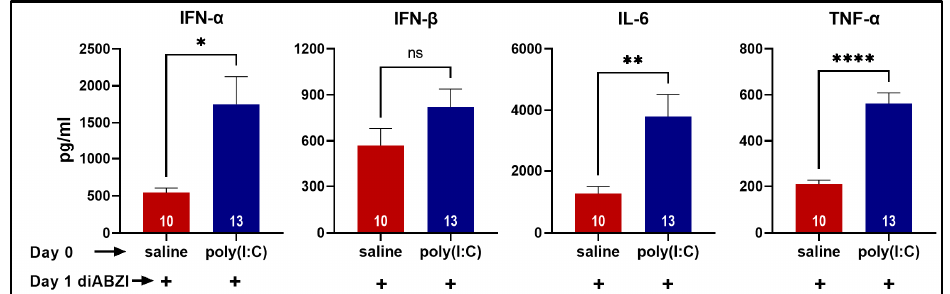
Figure 7. Exaggerated serum cytokine levels after subcutaneous injection of diABZI in mice pre- treated with poly (I:C). On day 0, mice were injected with either poly (I:C) in saline (2 mg/kg) or saline alone, ip. On the following day, all mice were injected with diABZI (2.5 mg/kg s.c.), and tail bleeds were collected 4 h later. Serum cytokines (IFN- α , IFN- β , IL-6, TNF- α ) were measured using a multiplex bead-based assay. Cytokine levels in the control groups were below the limit of detec- tion.* p < 0.05, ** p < 0.01, **** p < 0.0001, ns not significant.